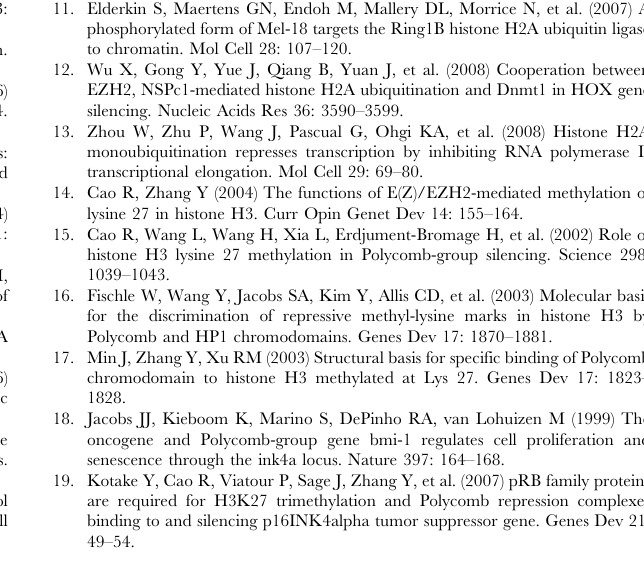
Table S3 Bmi1-dependent peaks corresponding to gene pro- moter regions.